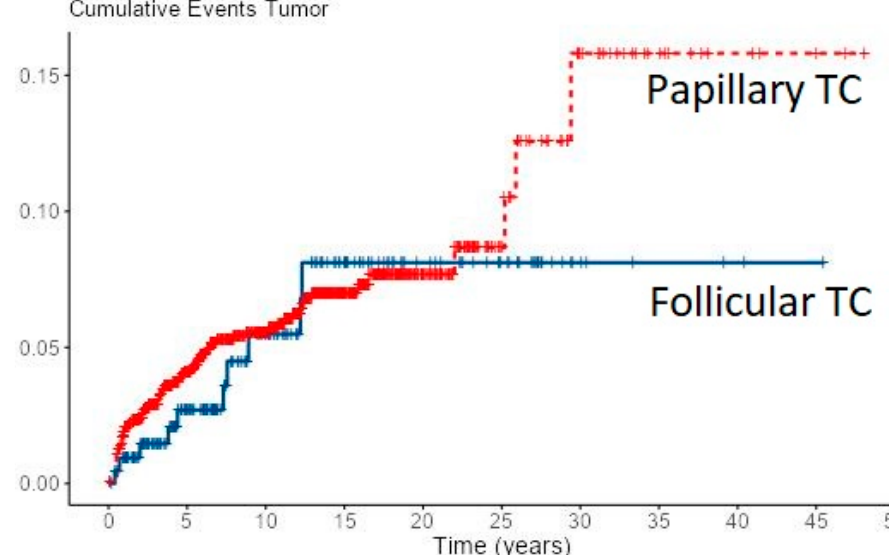
Figure 1. Cumulative events for local recurrence of PTC and FTC.